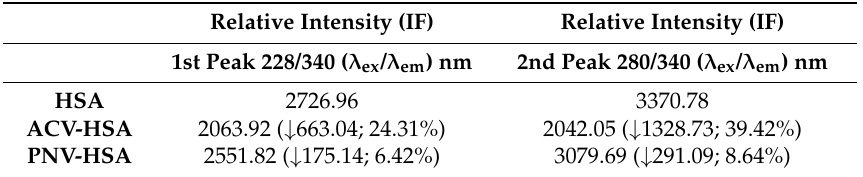
Table 3. Data obtained from 3D fluorescence experiments for HSA in presence and absence of ACV and PNV.